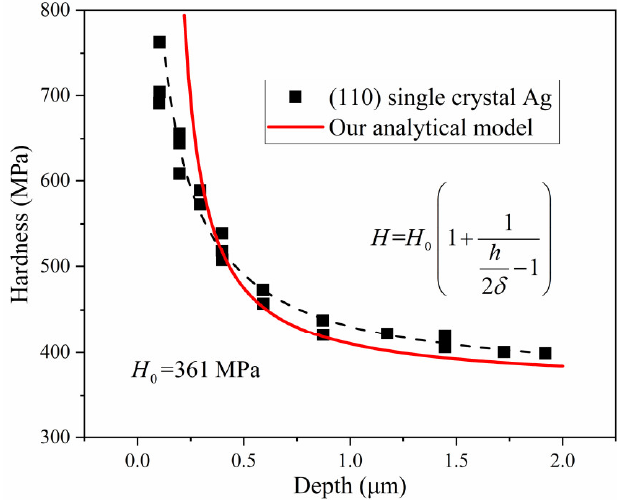
Figure 17. Comparison of analytical model and experiment. Here, the ISE phenomenon resulting from strain gradient can be also explained by our model based on external factors when δ = 0.06 µ m. Data from Refs. [3,19].